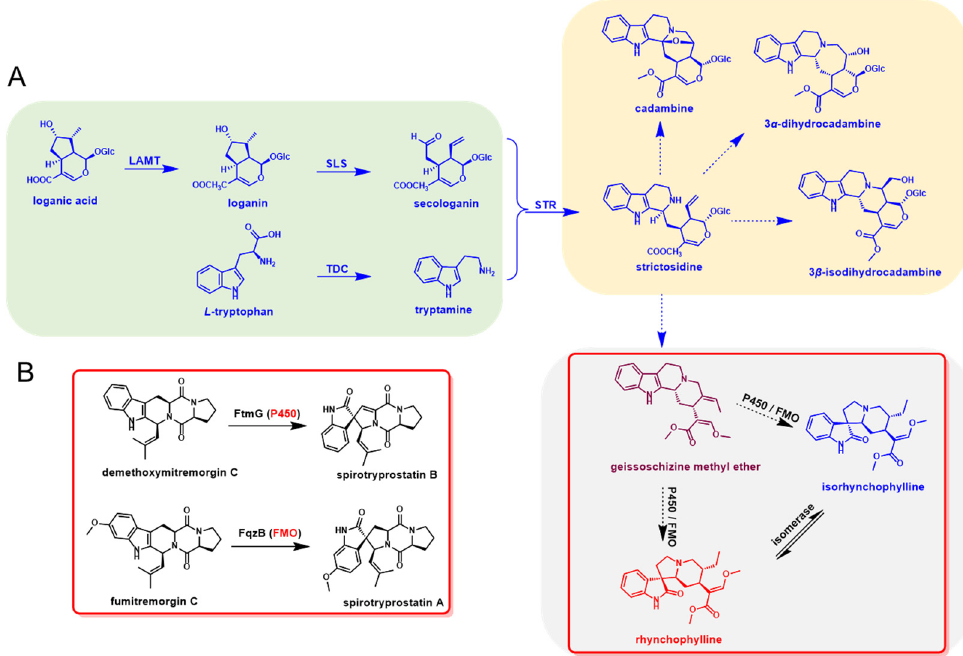
Figure 1. Proposed biosynthetic pathway of rhynchophylline and isorhynchophylline. ( A ) Metabo- lites and enzymes involved in the indole alkaloids biosynthetic pathway in U. rhynchophylla . ( B ) The homologs (P450 and FMO) for spiro-indole alkaloids formation in microbial natural product bio- synthesis.